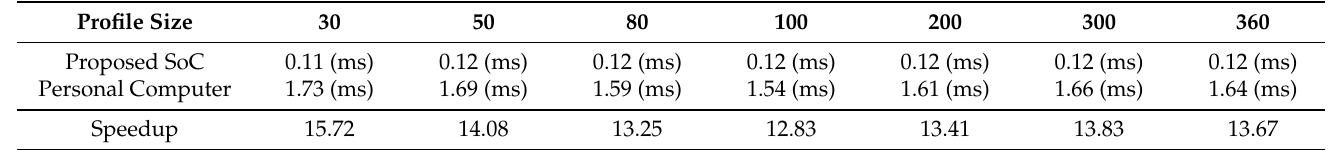
Table 7. The latency t 2 for updating profile P with various profiles sizes p given a new response record ( x ∗ , y ) .